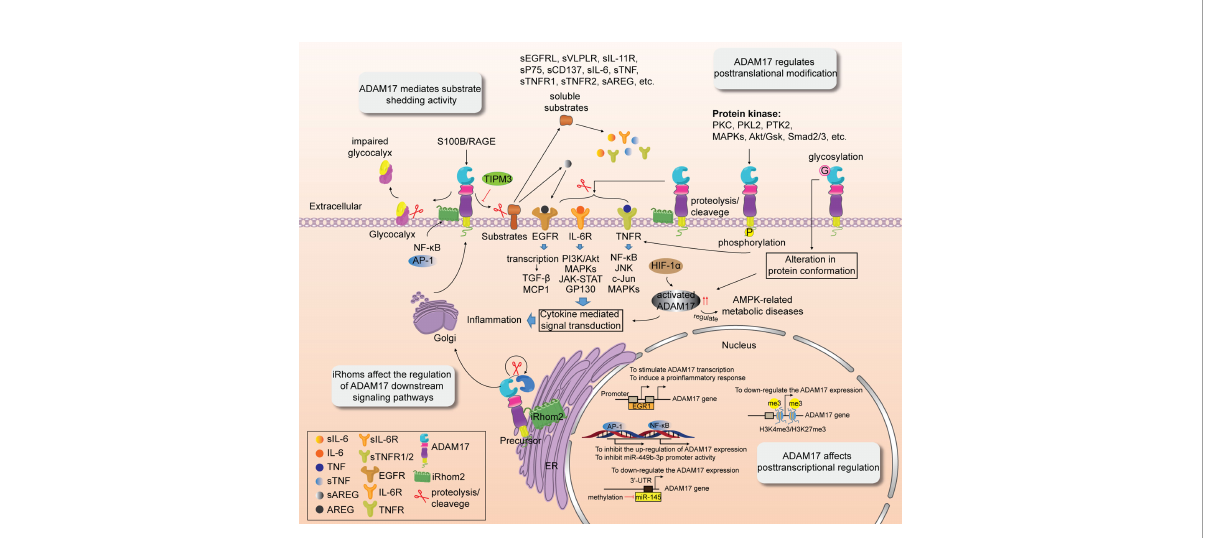
FIGURE 2 Multiple regulatory roles of ADAM17. ADAM17 activity is affected by transcriptional regulation, and post-transcriptional and post-translational modi fi cation. ADAM17 activity is also associated with substrate shedding. iRhoms affect the shedding of ADAM17 and regulation of its downstream signaling